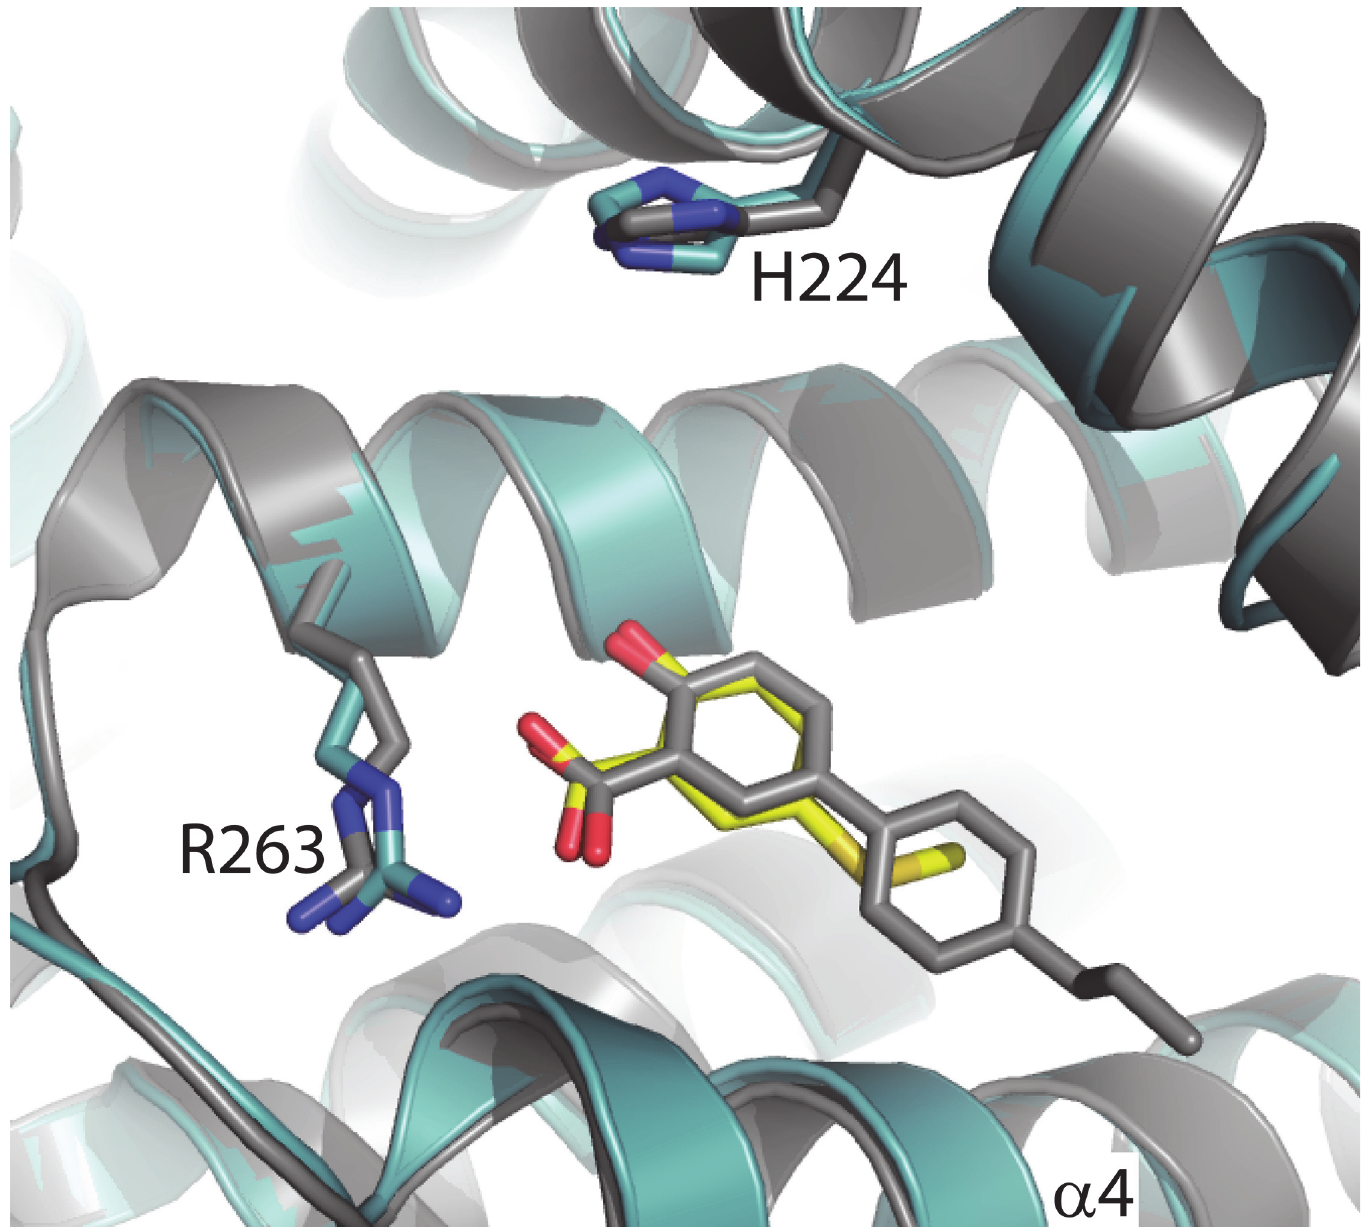
Fig 7. The structure of MBP-MCL1 bound to fragment 5 determined at 1.9 Å . Fragment 5 (yellow) binds similarly in comparison to the elaborated ligand from PDB ID 4OQ6